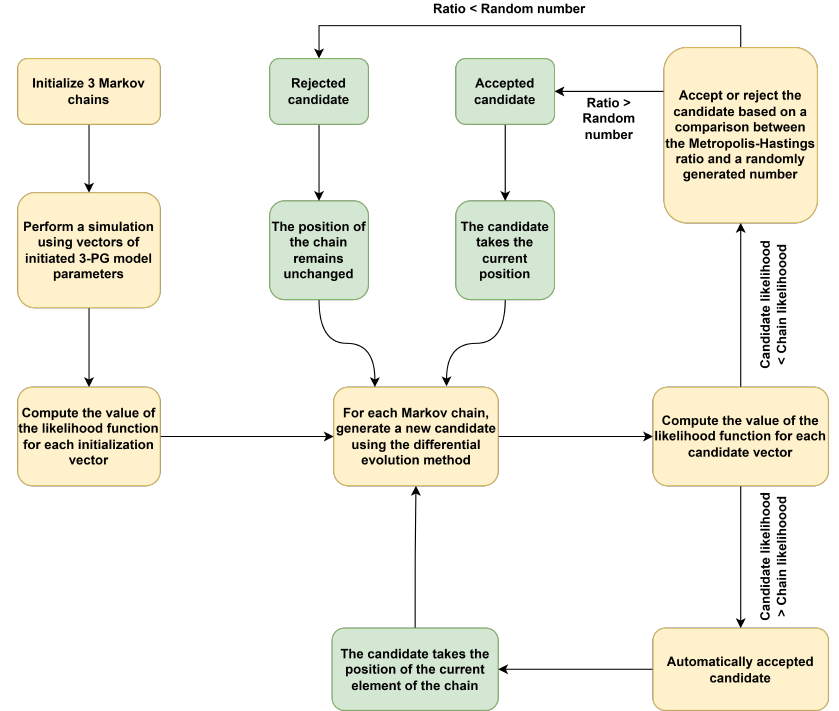
Figure 3. Flowchart of the DE-MC method (Differential Evolution-Markov